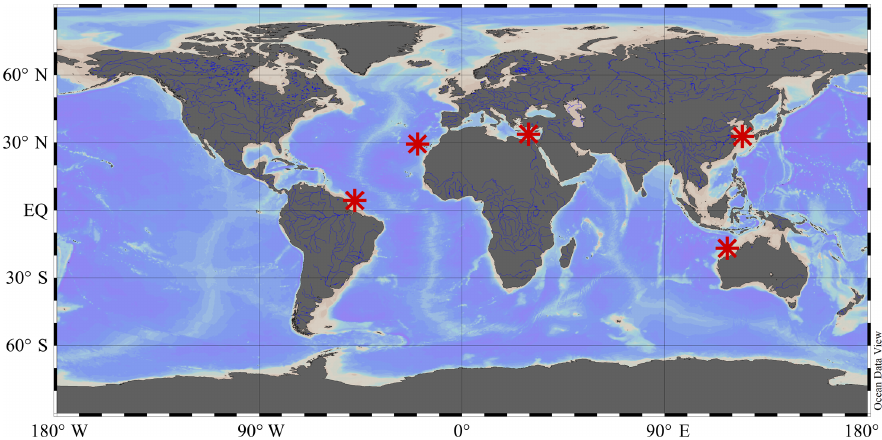
Figure 3. Areas where we consider statistical characteristics of internal